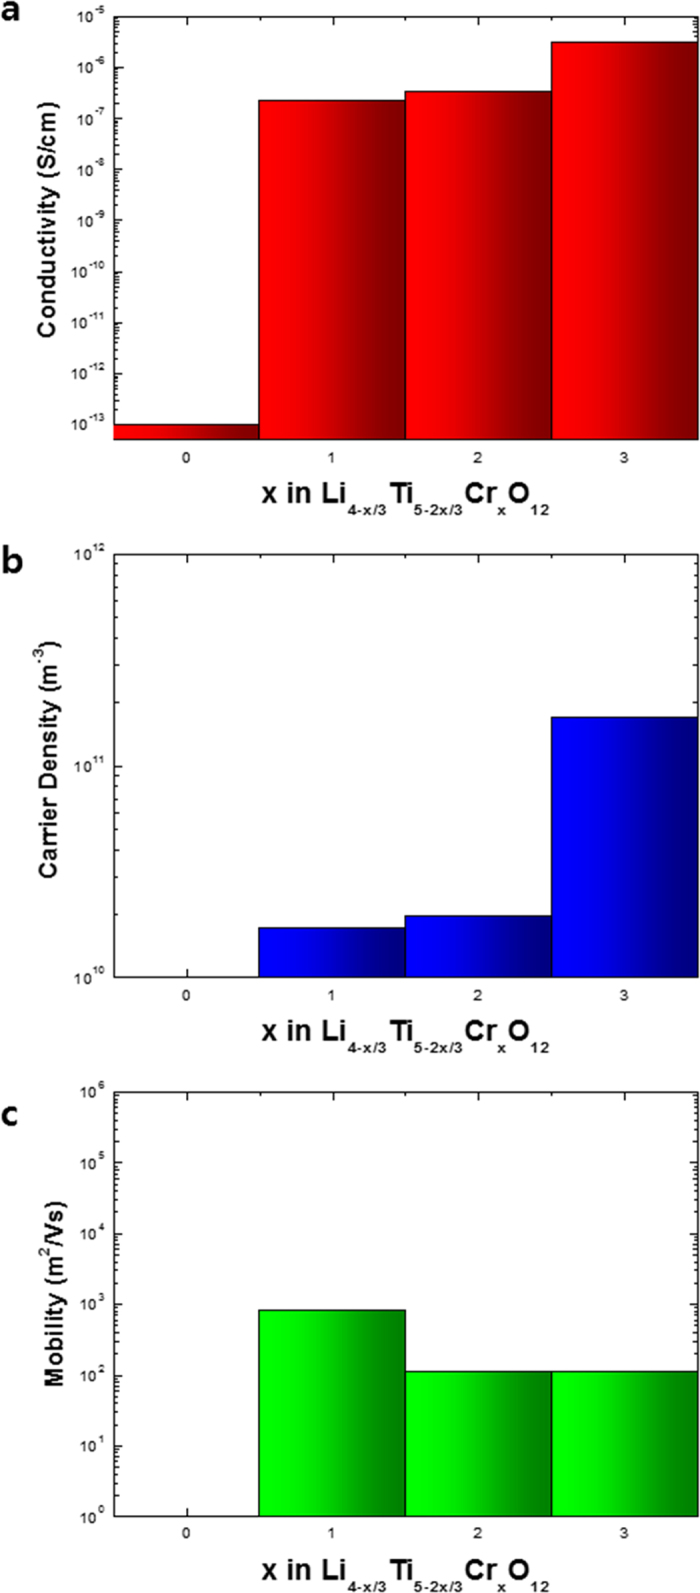
Electronic conductivity, Carrier density and Mobility of Li4−x/3Ti5−2x/3CrxO12 (x = 0, 1, 2, 3).